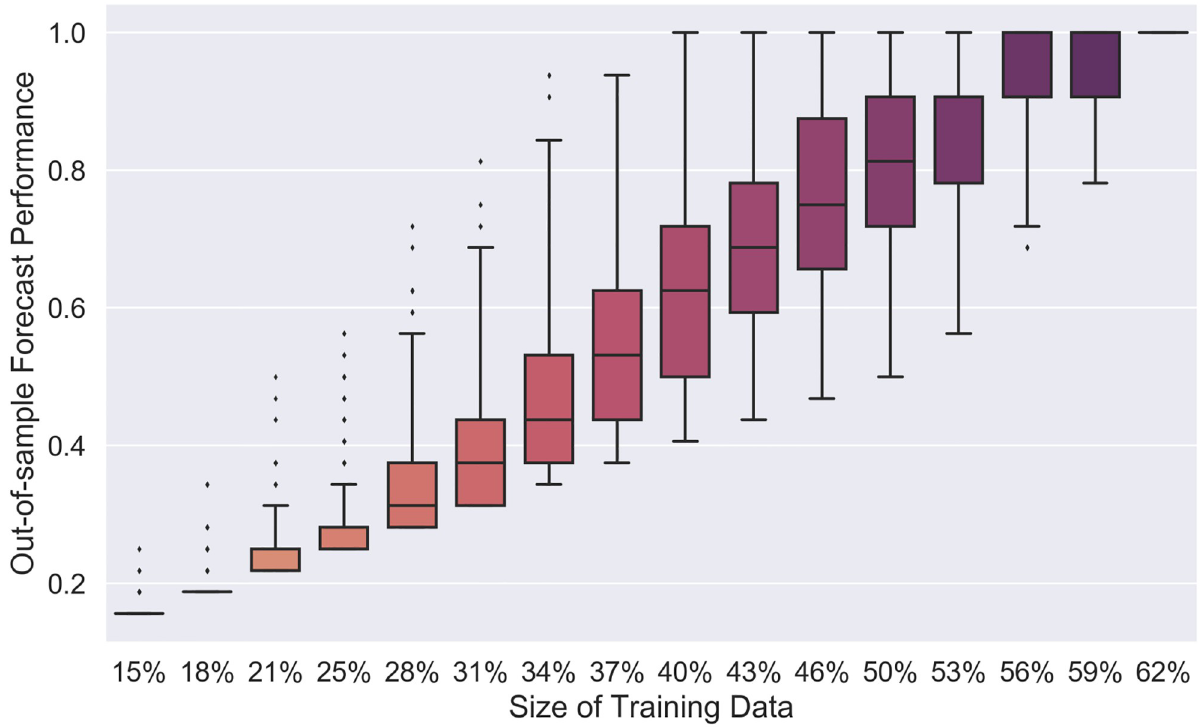
Fig 9. The out-of-sample forecast performance for the vital status of COVID-19 patients. The x -axis shows the percentage of the full input space that was used as the training data. For each training-data set size, we randomly sampled 1000 training data sets and measured the forecast performance. For randomly chosen training-data sets with a size of at least 56% of the entire valid input space, the median of the out-of-sample forecast performance equals 1.